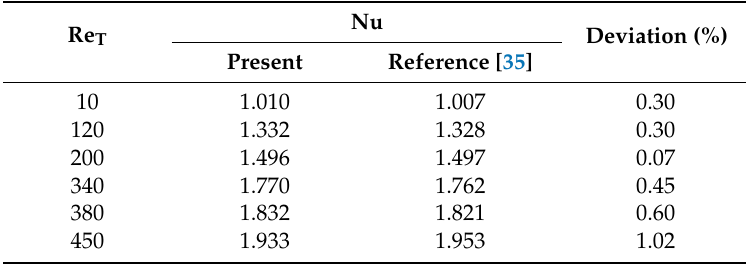
Table 3. Comparisons of the Nusselt numbers at the left vertical wall.